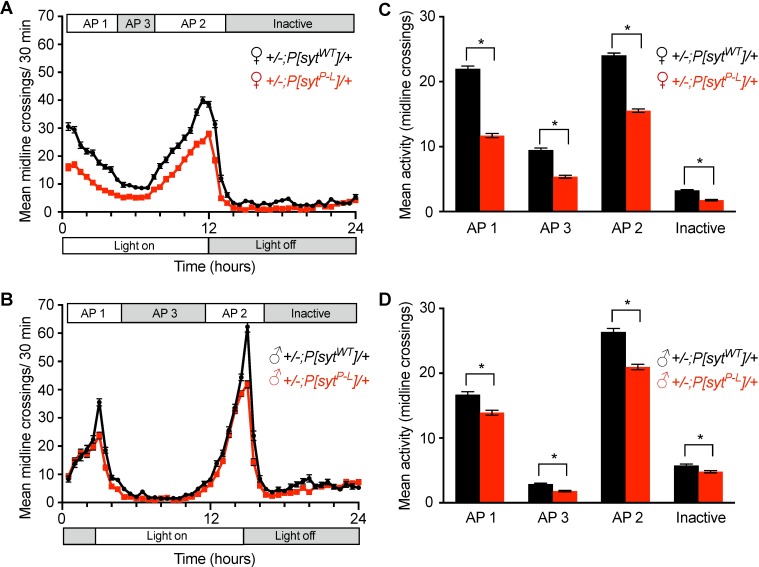
The sytP-L mutation affects locomotor activity in Drosophila.(A, B) Average activity per 30 minutes for an averaged 24-hour day in a 6-day Drosophila Activity Monitoring Assay in 5–7 day old females (A) and males (B). (C, D) Distinct activity periods (AP) were averaged for females (C, n = 48 for each genotype) and males (D, n = 48 for +/-;P[sytP-L]/+, n = 45 for control). P[sytP-L] heterozygotes were significantly less active than controls during all activity periods in both males and females (* indicates p < 0.001, student t-tests). Error bars depict SEM.